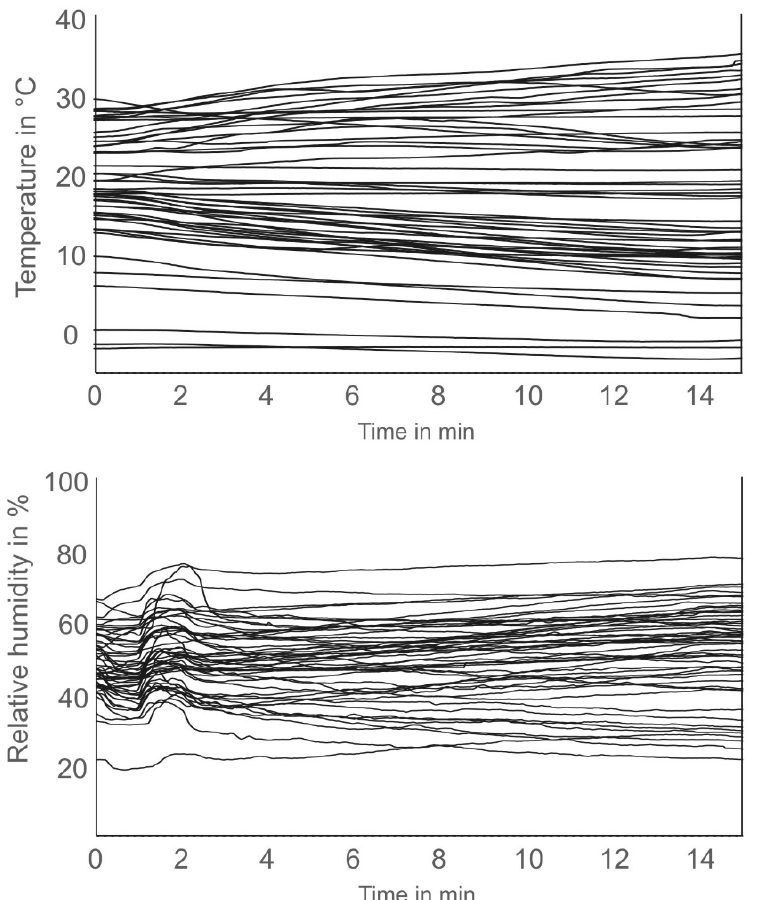
Figure 3. Course of temperature and relative humidity in the bioaerosol chamber during the 54 experiments. 54